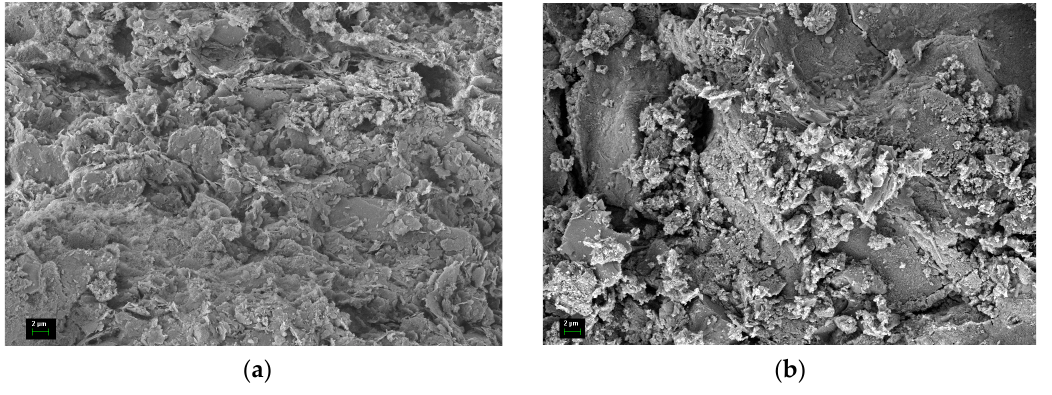
Figure 5. Superficial SEM pictures for ( a ) functional ceramsite and ( b ) bio-ceramsite.